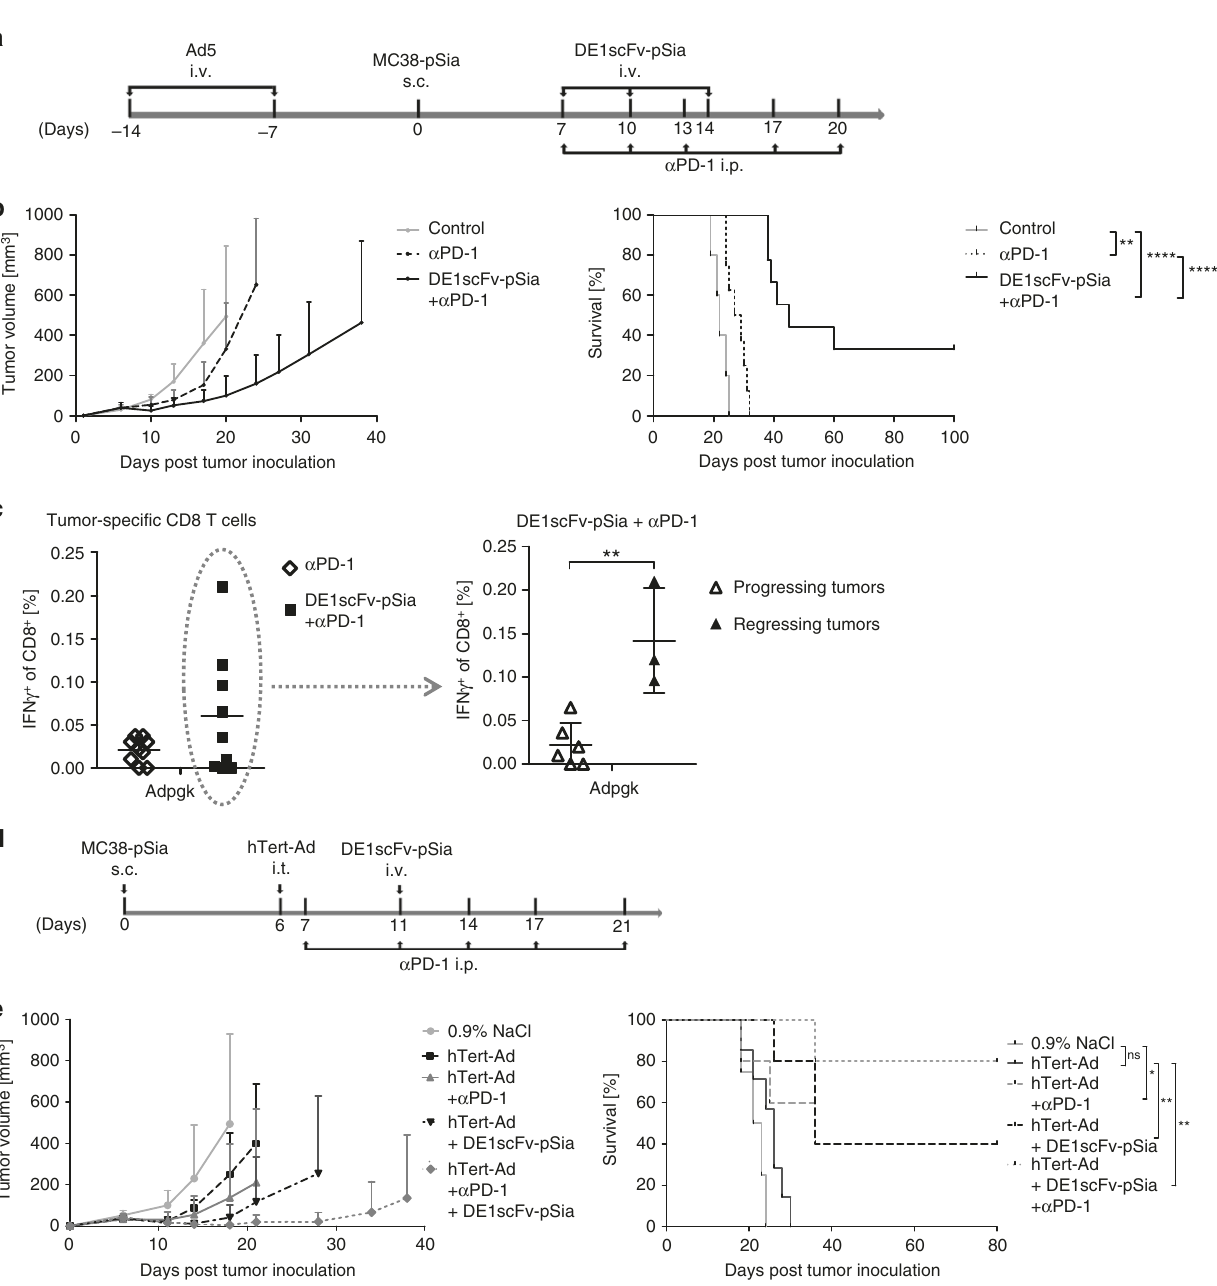
Fig. 6 Ab-retargeting sensitizes tumors for PD-1 checkpoint inhibition facilitating long-term survival. a Subcutaneous MC38-pSia tumors were established in Ad5-vaccinated mice. Seven days after tumor cell injection, animals were treated with an antagonistic antibody against PD-1 as monotherapy ( α PD-1) or in combination with DE1scFv-pSia antibody retargeting (DE1scFv-pSia + α PD-1) or remained untreated (control). b Tumor development and survival (group size: α PD-1: n = 8, ms: 28 days; DE1scFv-pSia + α PD-1: n = 9, ms: 45 days, control: n = 5, ms: 22 days) was monitored. c Blood samples were drawn during treatment on day 13 after start of treatment, and splenocytes were stimulated with the peptide ASMTNMELM to detect CD8 T-cell responses against the Adpgk-R304M neoepitope. Responsiveness of CD8 T cells to peptide stimulation was measured via intracellular IFN γ -staining and fl ow cytometry. Left panel: α PD-1 vs. DE1scFv-pSia + α PD-1 ( n = 9 per group). Right panel: individuals of the DE1scFv-pSia + α PD-1 treatment group were split in those showing tumor progression ( n = 6) and tumor-free animals: ( n = 3). d Subcutaneous MC38-pSia tumors were established in Ad5-naive mice. Tumor-bearing